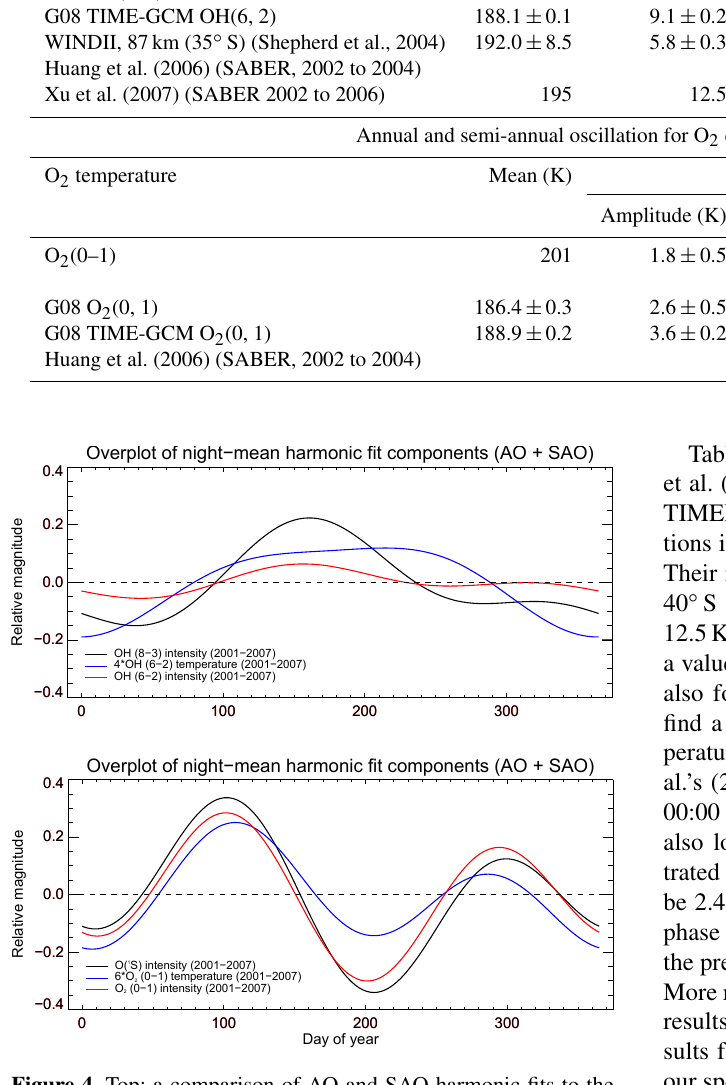
Figure 4. Top: a comparison of AO and SAO harmonic fits to the OH(6–2) rotational temperature and intensity from the spectrome- ter and the corresponding OH(8–3) intensity from the 3FP for the period 2001 to 2007. Bottom: as for top panel, but for the O 2 (0–1) rotational temperature and intensity and the corresponding O( 1 S) intensity from the